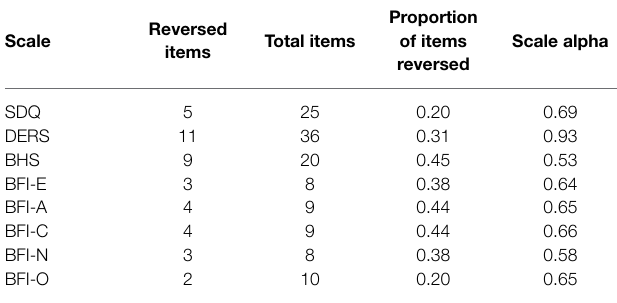
TABLE 2 | Proportion of reverse-coded items and alpha by